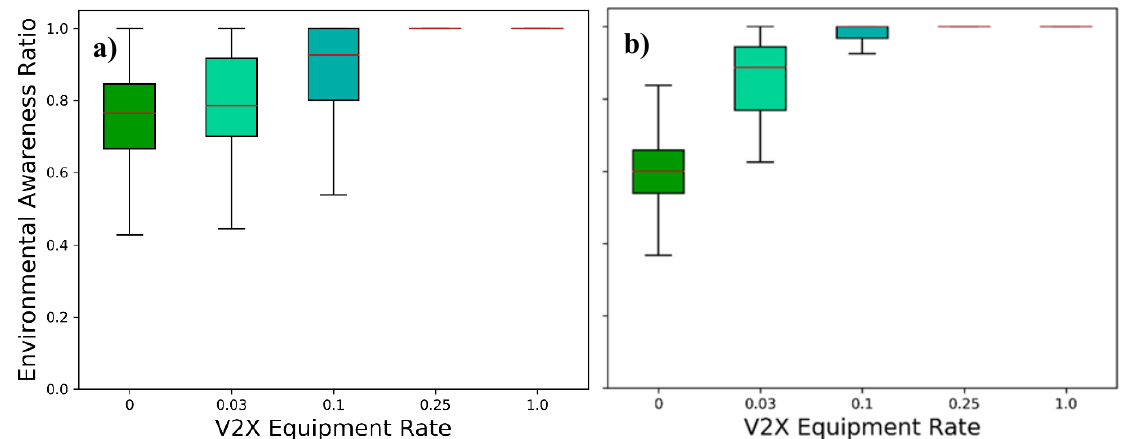
Figure 10. Environmental Awareness Ratio in dependence of the V2X equipment rate for ( a ) the low-density scenario and ( b ) the high-density scenario for an area with a diameter of 250 m, showing typical data range (whiskers), interquartile range (boxes) and median (red-colored